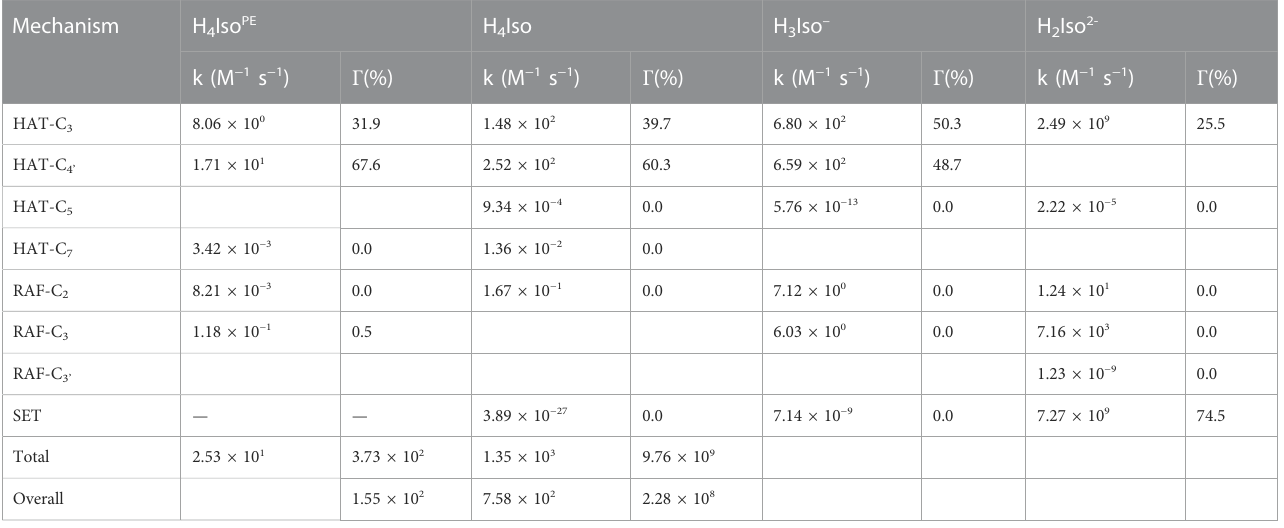
TABLE3Rateconstants(k) a andbranchingratios( Γ )ofthereactionbetweenisorhamnetinand*OOHradicalin1:1ratio,computedat298.15 K,forthedifferentspecies present in solution at pH = 7.4 Mechanism